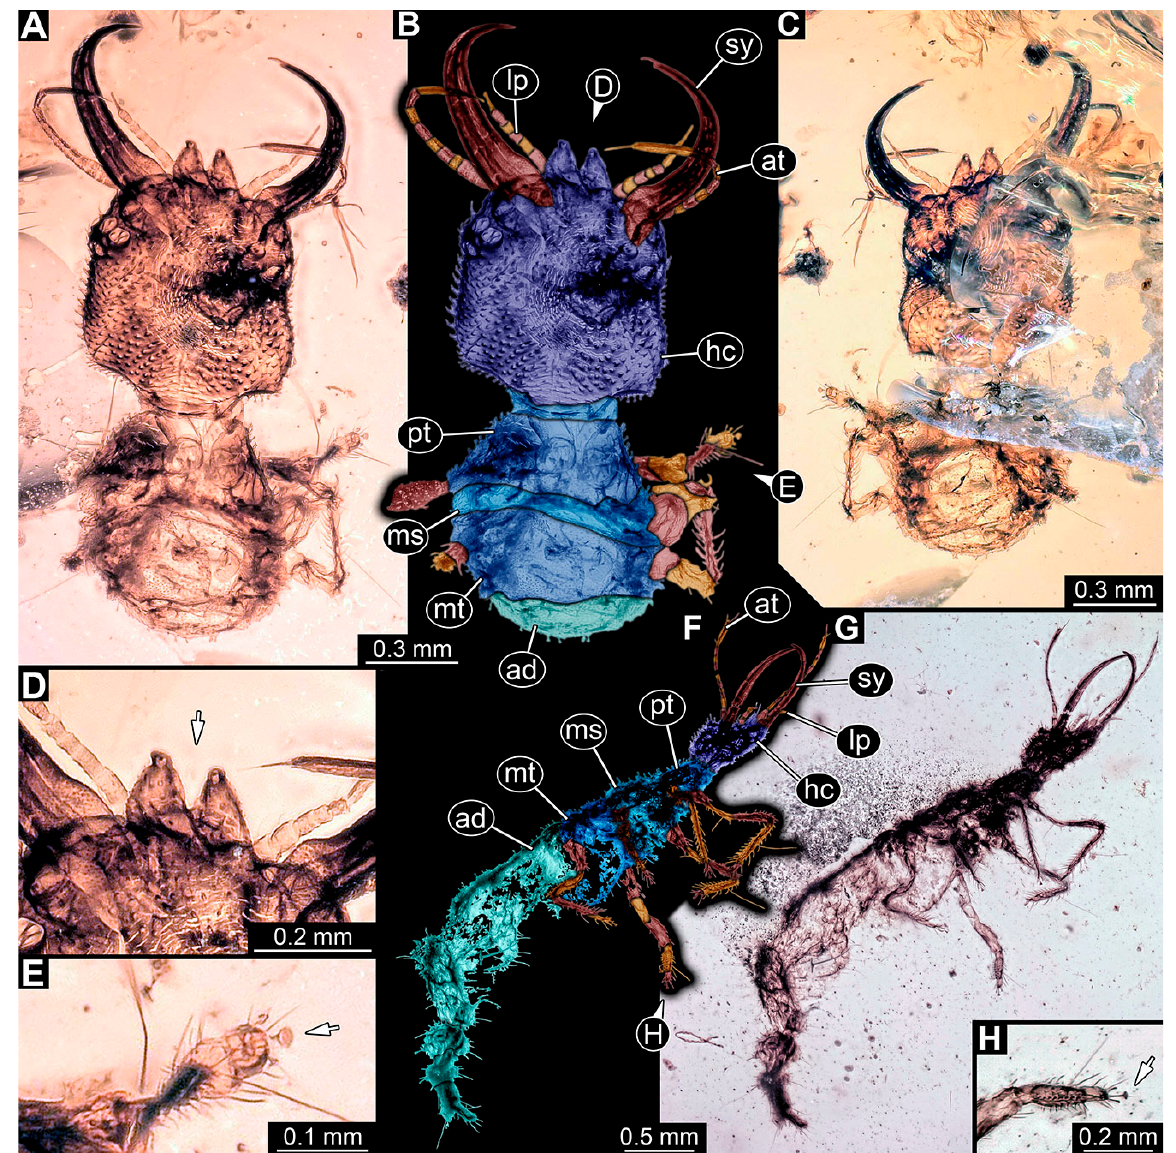
appendages are visible (Figure 2H). The specimen has an approximate length of 3.9 mm. This specimen was not included in the final analysis.